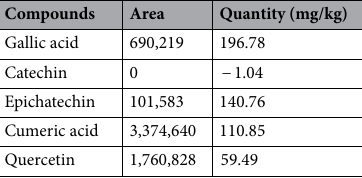
Table 7. HPLC analysis of Dodonaea viscosa flower methanol extract.